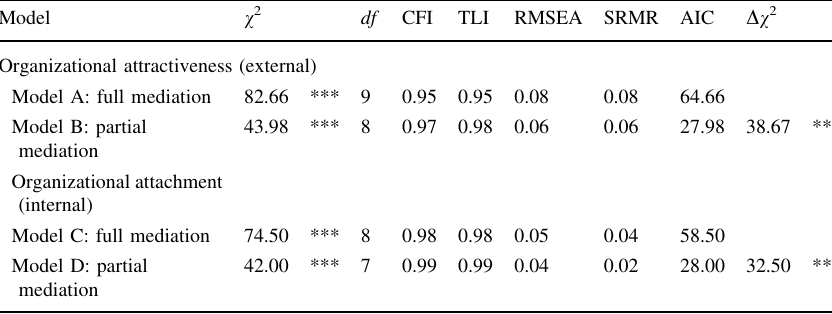
Table 6 Fit statistics for hypothesized and alternative model